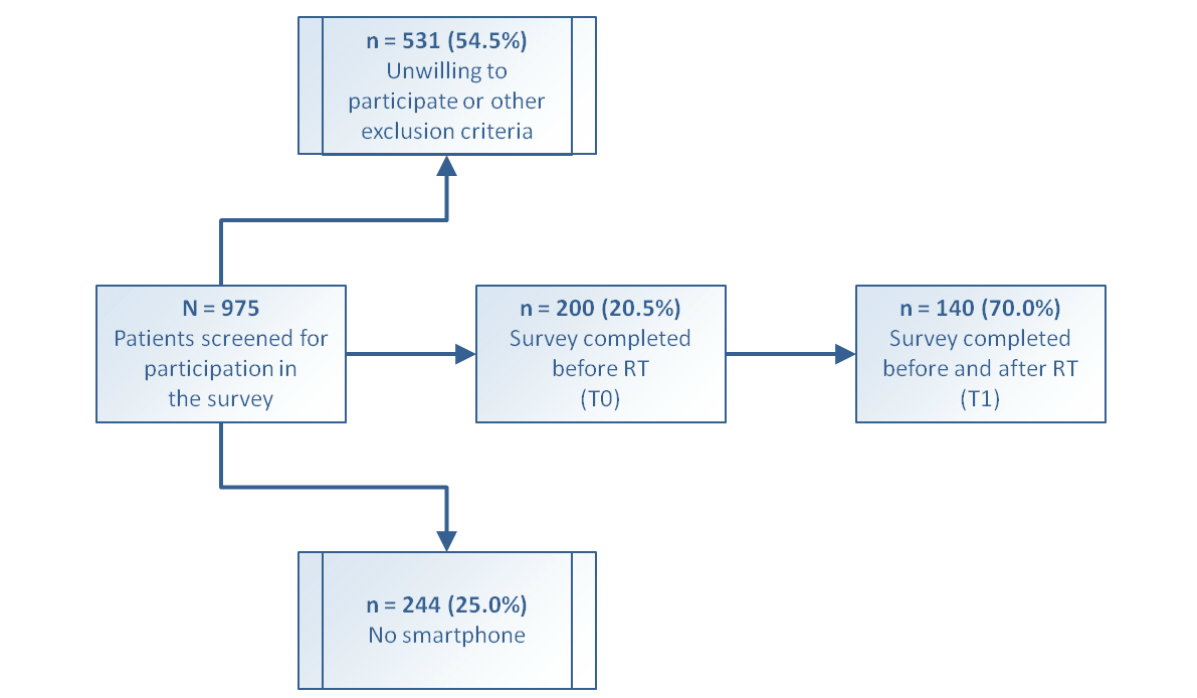
Figure 1. Flowchart illustrating patient screening and recruitment workflow. RT: